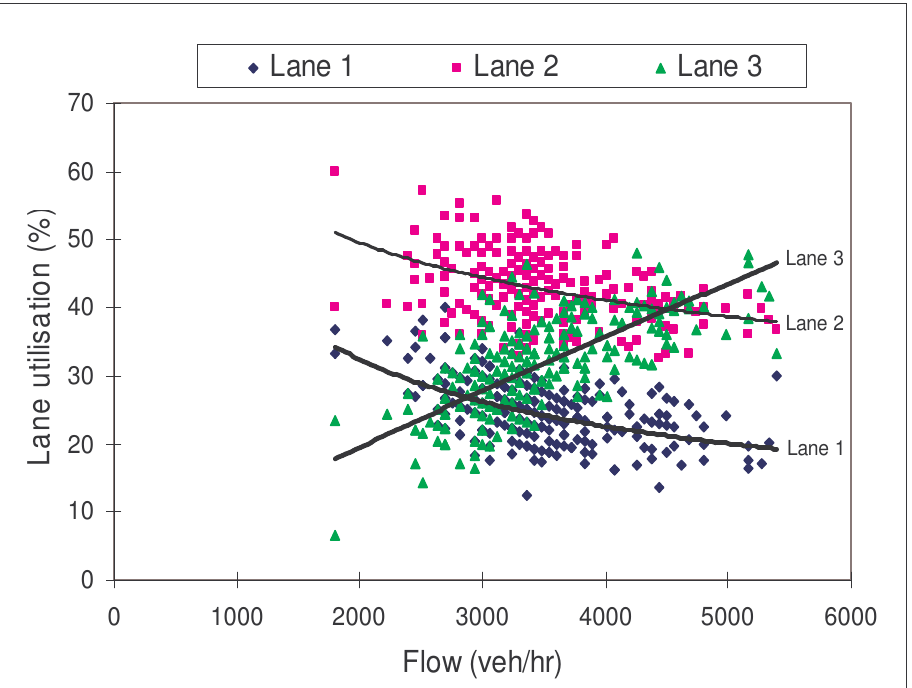
Figure 6. Lane utilisation of the mainline of the M27 (from Brackstone et al.,